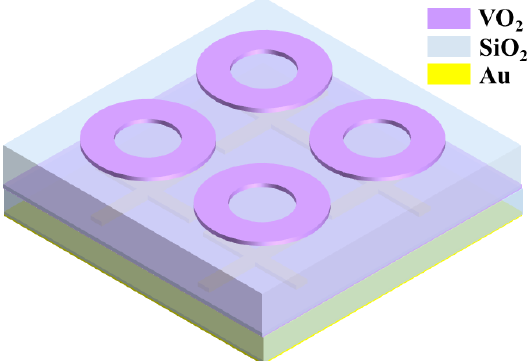
Figure 12. VO 2 -based broad-band absorption and narrow-band absorption structure [151].